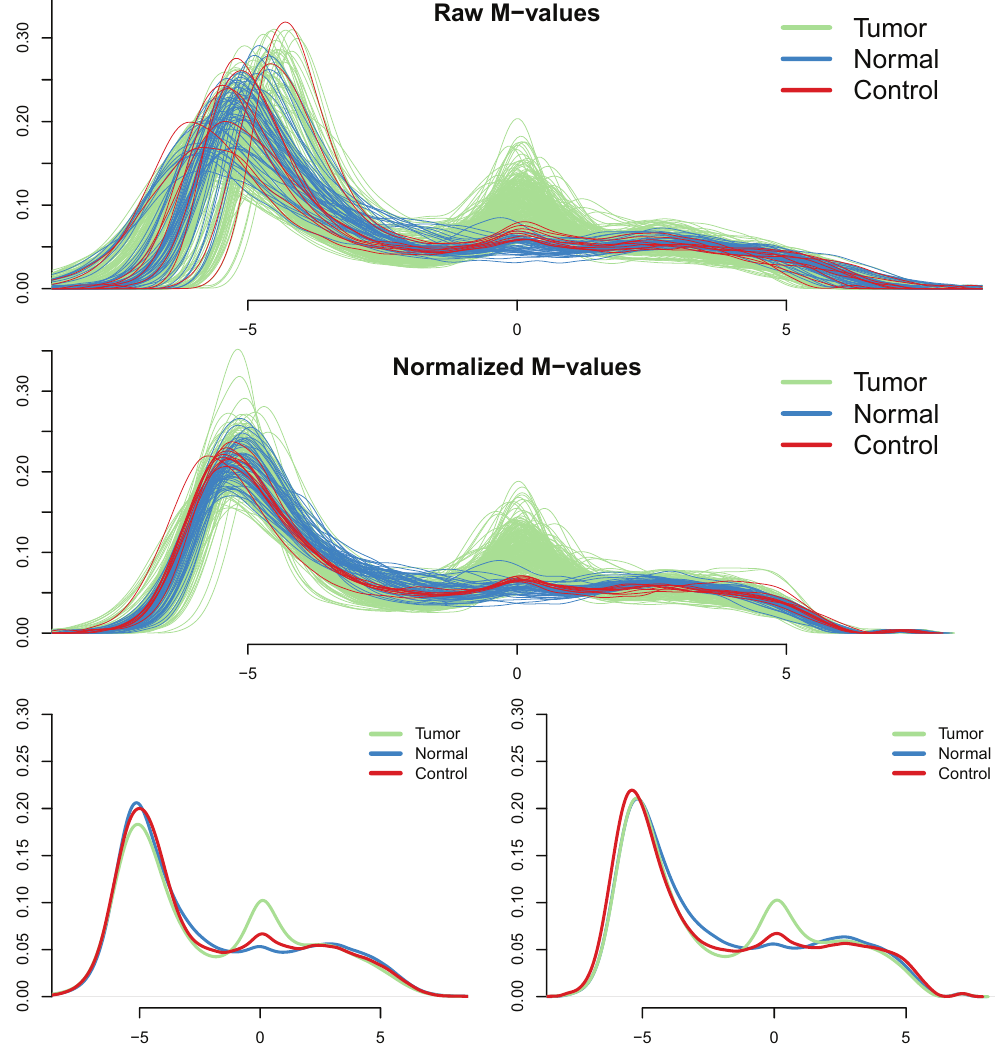
Figure 3. Visualization of cancer/normal differences in the TCGA dataset, before and after normalization. In the first two plots are shown the densities of the M-values for Type I green probes before ( a ) and after ( b ) functional normalization as presented in the shinyMethyl interactive interface. Green and blue densities represent tumor and normal samples respectively, and red densities represent 9 technical replicates of a control cell line. The last two plots show the average density for each sample group before and after normalization. Functional normalization preserves the expected marginal differences between normal and cancer, while reducing the variation between the technical controls (red